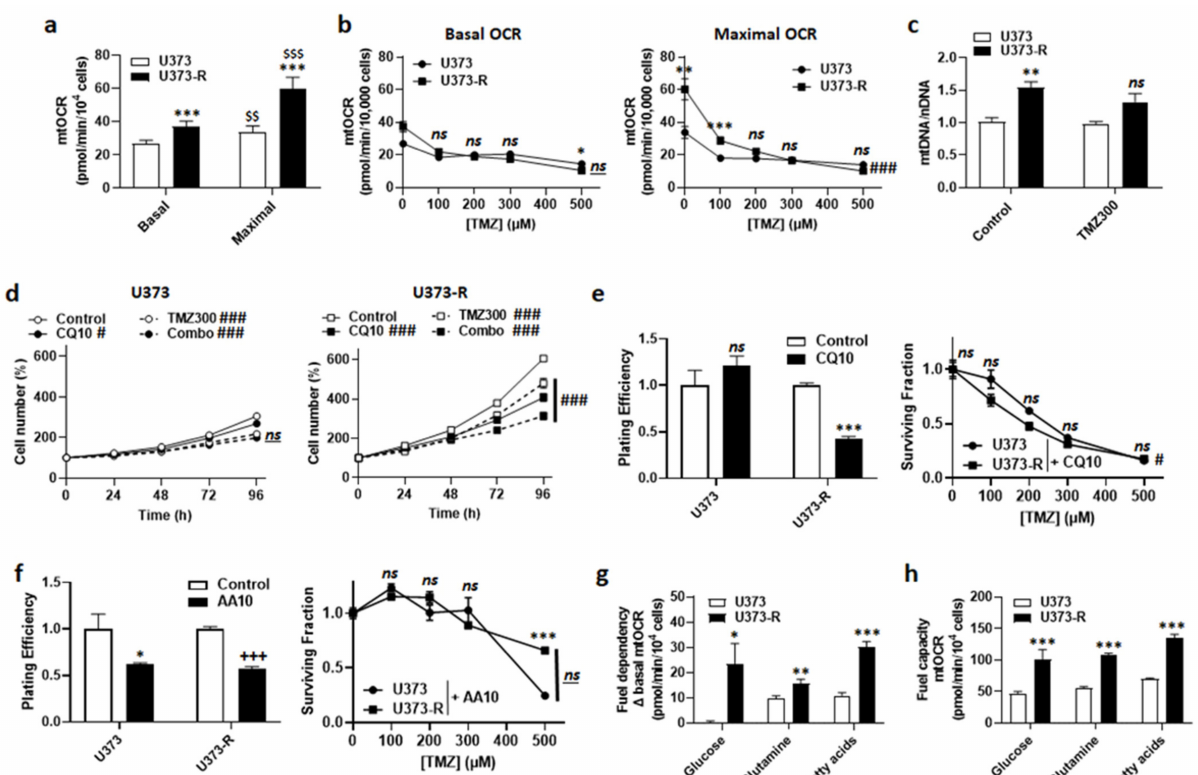
Figure 4. Fitter, more oxidative mitochondria participate in the resistance of U373-R cells to TMZ. ( a ) The basal and maximal mitochondrial oxygen consumption rates (mtOCRs) of U373 and U373-R glioblastoma cells were determined on a Seahorse XF96 bioenergetic analyzer ( n = 6). ( b ) The cells were treated for 72 h with increasing doses of TMZ, after which basal mtOCRs ( left ) and maximal mtOCRs ( right ) were measured ( n = 14–24). ( c ) The cells were treated for 72 h ± TMZ300, after which the mitochondrial DNA/nuclear DNA ratios (mtDNA/nDNA) were determined using RT-qPCR ( n = 6). ( d ) Number of U373 ( left ; n = 12–16) and U373-R ( right ; n = 12–16) cells over time upon treatment ± 10 µ M of autophagy inhibitor chloroquine (CQ10) ± TMZ300. ( e ) Clonogenic assays of U373 and U373-R cells that were pretreated for 72 h with increasing concentrations of TMZ ± 10 µ M chloroquine (CQ10). Displayed are the plating efficiency of TMZ-untreated cells ( left ; n = 3–5); and the surviving fractions ( right ; n = 6), where the data are normalized to the number of corresponding TMZ-untreated cells. ( f ) As in ( e ) but using 10 µ M of ETC Complex III inhibitor antimycin A ( n = 3–6). ( g ) The glucose, glutamine, and fatty acid fuel dependency of U373 and U373-R cells that was determined on a Seahorse XF96 bioenergetic analyzer ( n = 6–8). ( h ) The glucose, glutamine, and fatty acid fuel capacity of U373 and U373-R cells that was determined on a Seahorse XF96 bioenergetic analyzer ( n = 4–8). All data are shown as means ± SEM. * p < 0.05, ** p < 0.01, *** p < 0.005, ns: p > 0.05 versus the corresponding U373 cells; # p < 0.05, ### p < 0.005, ns: p > 0.05 for whole curve comparison; $$ p < 0.01, $$$ p < 0.005 versus U373 basal; +++ p < 0.005 versus untreated U373-R; by one-way ANOVA with Tukey’s post hoc test ( a ), two-way ANOVA with Sidak’s post hoc test ( b , d , e right , f right ) or Student’s t -test ( c , e left , f left , g , h